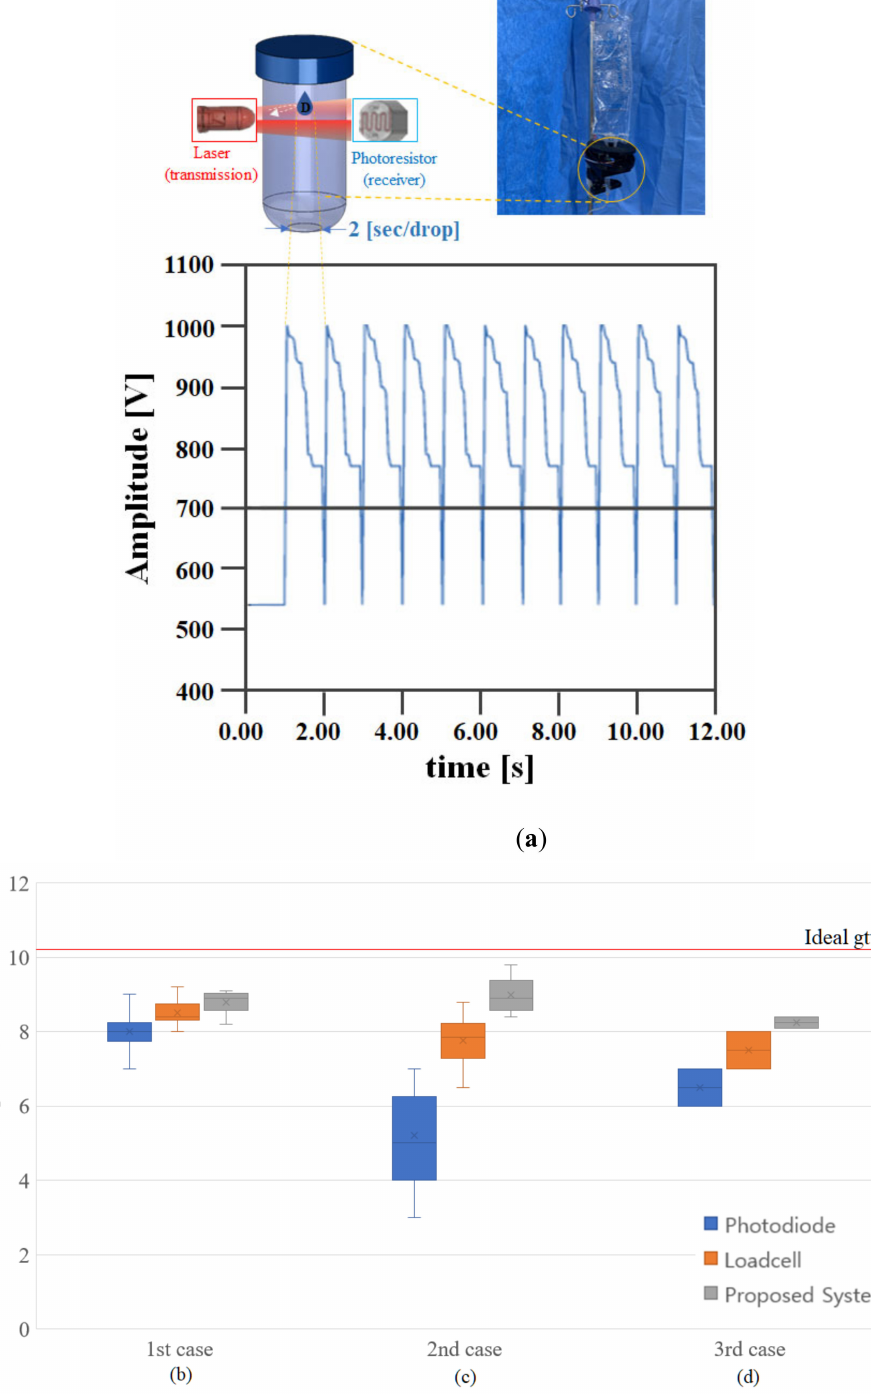
Figure 6. Graph of variance associated with the ( a ) experiment conducted considering a rate of < 2 s/drop in the first case, ( b ) experimental results comparing single sensors and the proposed system under static conditions in the second case, ( c ) experimental results under moving conditions in a horizontal direction, and ( d ) experiment results under vertical movement conditions in the third